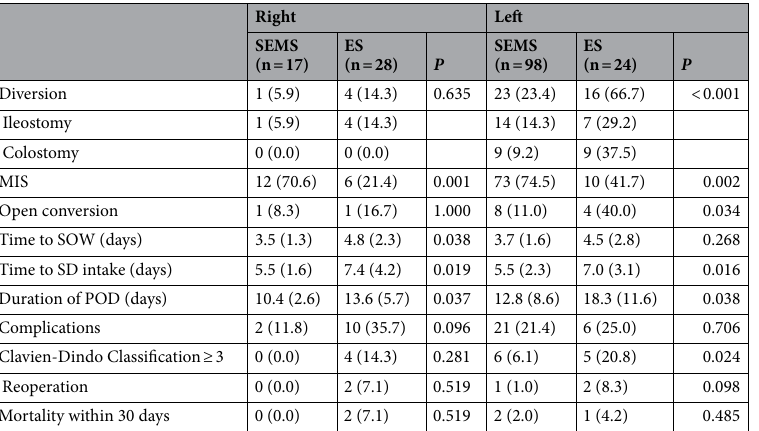
Table 4. Perioperative outcome according to location of colorectal cancer. Data are presented as the number of patients (%) or median (standard deviation) unless otherwise stated. SEMS self-expandable metallic stent, ES emergent surgery, n number, MIS minimal invasive surgery, SOW sips of water , SD soft diet , POD postoperative hospital days.